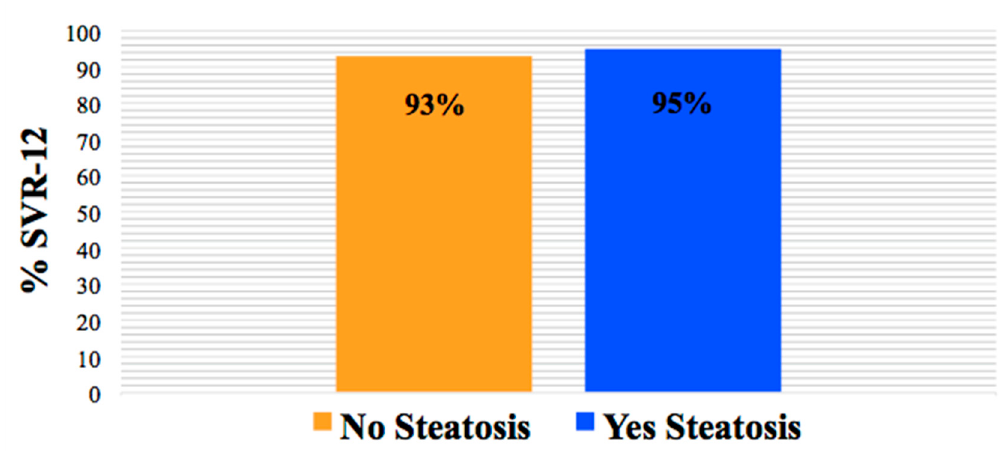
Figure 1. SVR-12 rate by the presence and absence of hepatic steatosis ( p > 0.05).